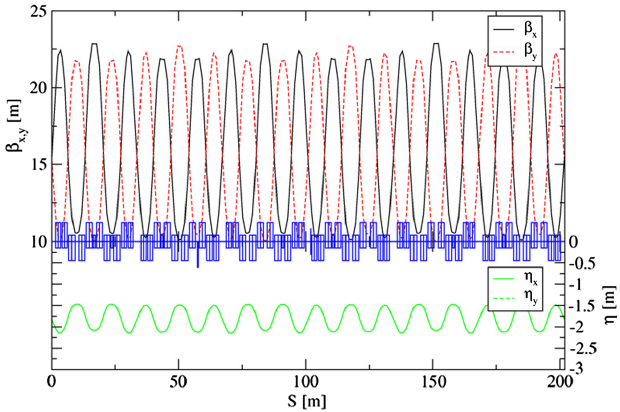
FIG. 9. The beta ( (cid:1) x;y ) and eta ( (cid:2) x;y ) functions over three superperiods of the AGS with four helices. A single helix of strength 1.9 T is placed at the middle of the three superperiods of the AGS. The corresponding betatron tunes appear in the 3rd row of Table II. The horizontal and vertical tune quadrupoles of the AGS are not